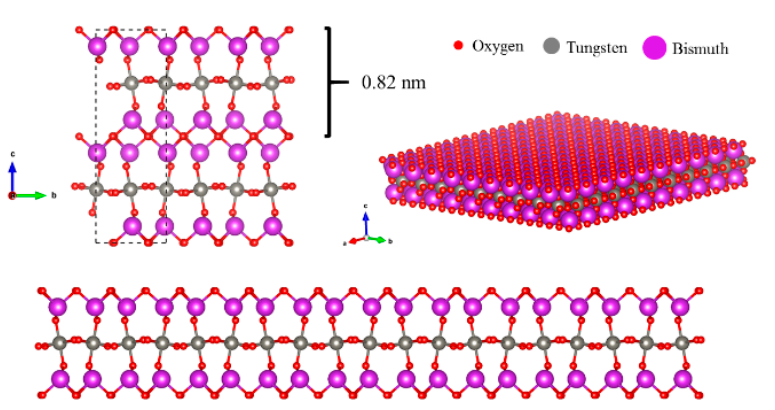
4 of 11 Figure 2. AFM images of the layered Bi 2 WO 6 nanosheets: ( a ) Surface topography, ( b ) three-dimen- sional image and ( c – e ) the corresponding height histograms.